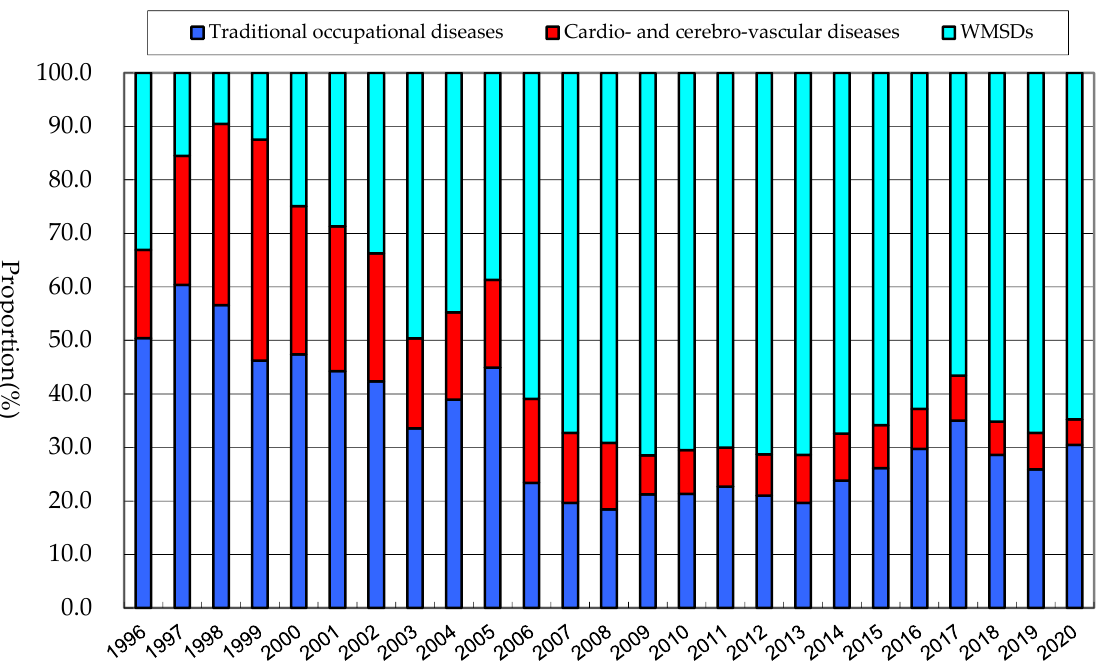
Figure 5. Distribution of WMSDs among occupational diseases by year. Small businesses with the number of workers of <100 occupied two-thirds of WMSDs reported for the last five years (68%) (Figure 6b). More than half of WMSDs occurred in small businesses with <50 workers (60%), while 13% of WMSDs occurred in large companies with 1000 or more workers. The percentage or number of WMSD cases was almost 3.5 times higher in men (78%) than that in women (22%) (Figure 6c). Workers aged > 50 years accounted for more than half of total WMSDs (57%), while young and middle-aged workers < 40 years occupied less than 20% of WMSDs (19%) (Figure 6d).